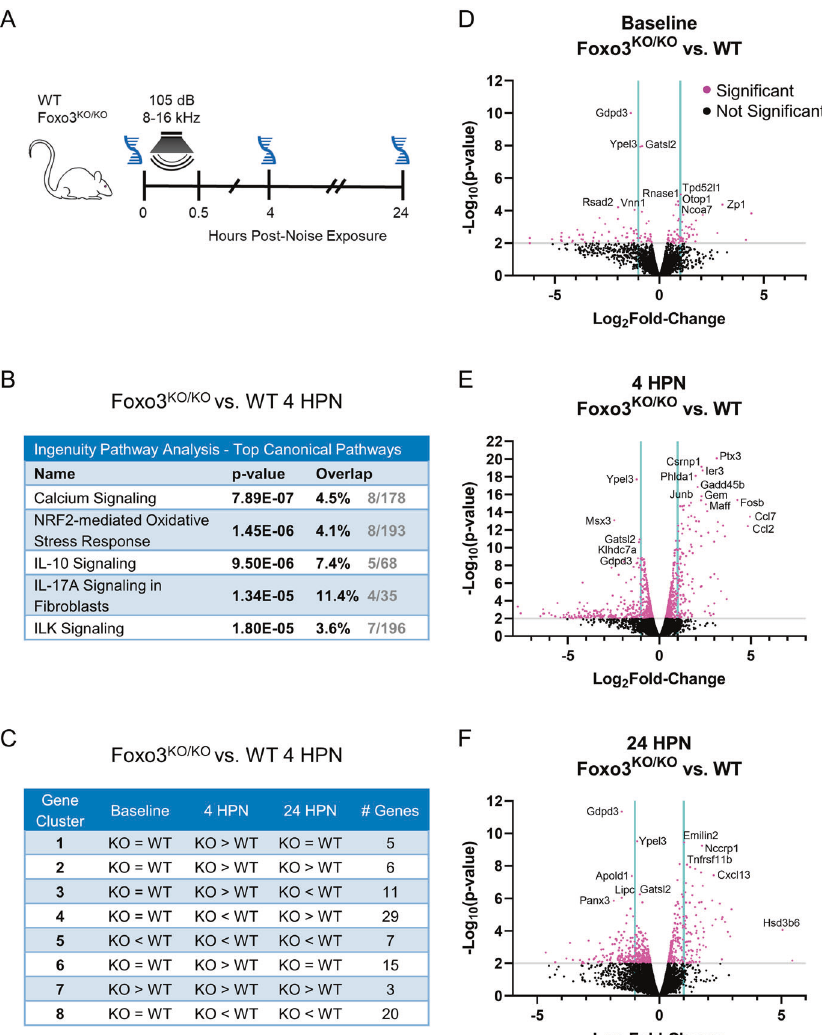
cochleae per genotype/condition). B Top canonical pathways in Foxo3 − / − versus WT cochleae at 4 HPN using Ingenuity Gene Ontology. The p - value indicates the statistical signi fi cance of the overlapping genes within the canonical pathway. C Gene expression clustering was performed for the Foxo3 − / − versus WT at 4 HPN to produce 8 clusters with similarly behaving genes. Clustering traces and the detailed gene table are available in Supplements (Fig. S6, Table S3). D – F Volcano plots of differentially expressed genes at baseline ( D ), 4 HPN ( E ), and 24 HPN ( F ). The y -axis represents − log 10 ( p -value) and x -axis is the log 2 fold-change. Signi fi cantly differentiated genes ( − log 10 ( p -value) ≥ 2) are denoted by pink dots above the gray line. Non-signi fi cant genes are represented by black dots. Cyan lines divide genes that fall between a − 1 to 1 log